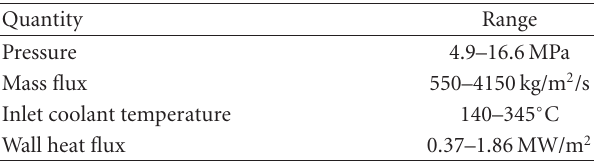
Table 1: Operating conditions of the NUPEC PWR test facility.